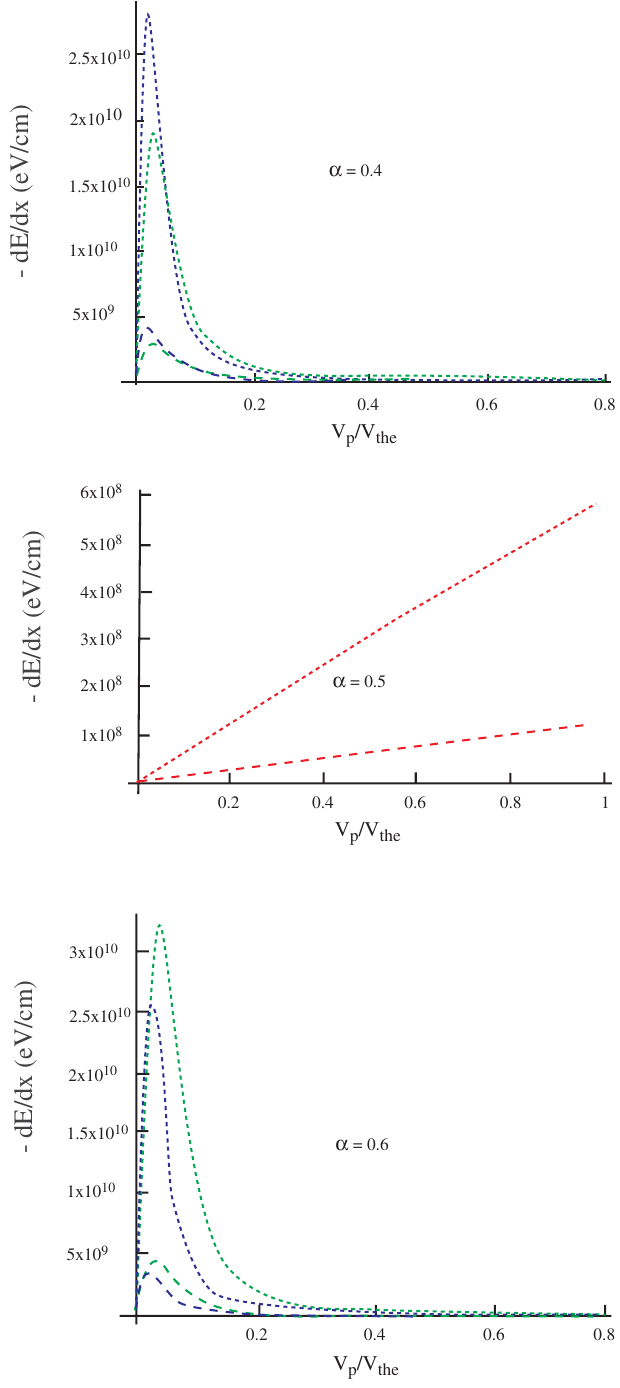
FIG. 10. (Color) He 2 þ (cid:1) dE=dx ( eV = cm ) in terms of V p =V the in a pbar- D þ BIM with total ion density ¼ 10 23 e cm (cid:1) 3 . (cid:1) denotes relative pbar concentration. Dark gray (red) refers to e stopping light gray (green) to pbar stopping, and black (blue) H þ stop- ping. TeV ¼ ( ) 100, and ( )